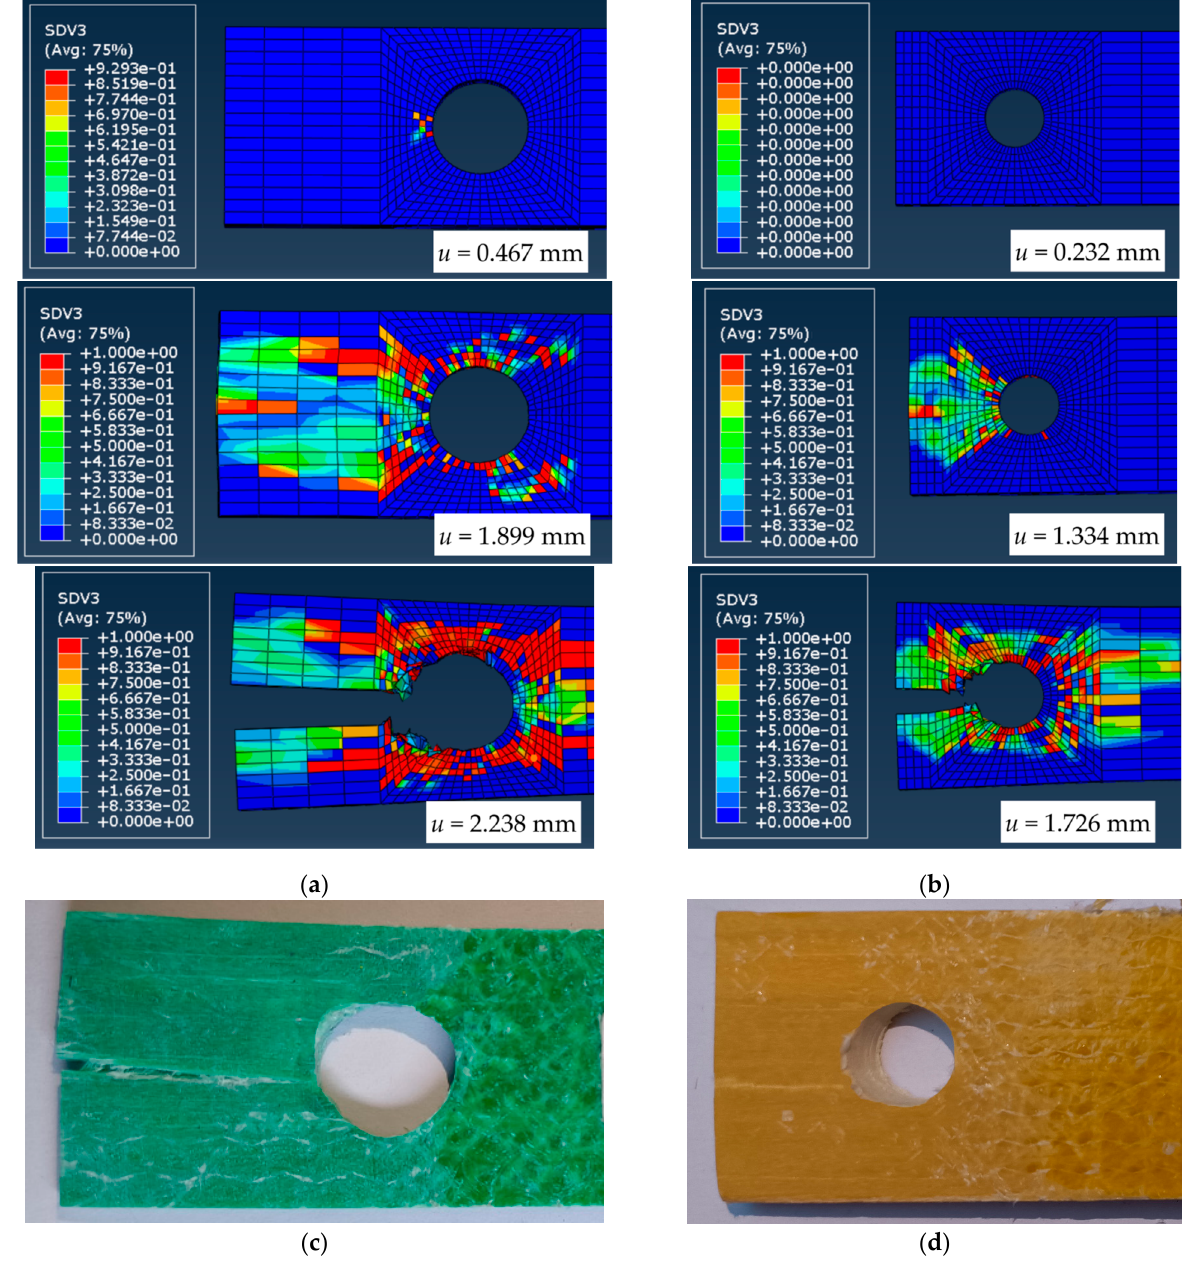
Figure 12. The simulated damage stages and test results comparison: ( a , b ) The numerically predicted damage stages of the A-12 and C-12 joints; ( c , d ) The corresponding failure patterns.